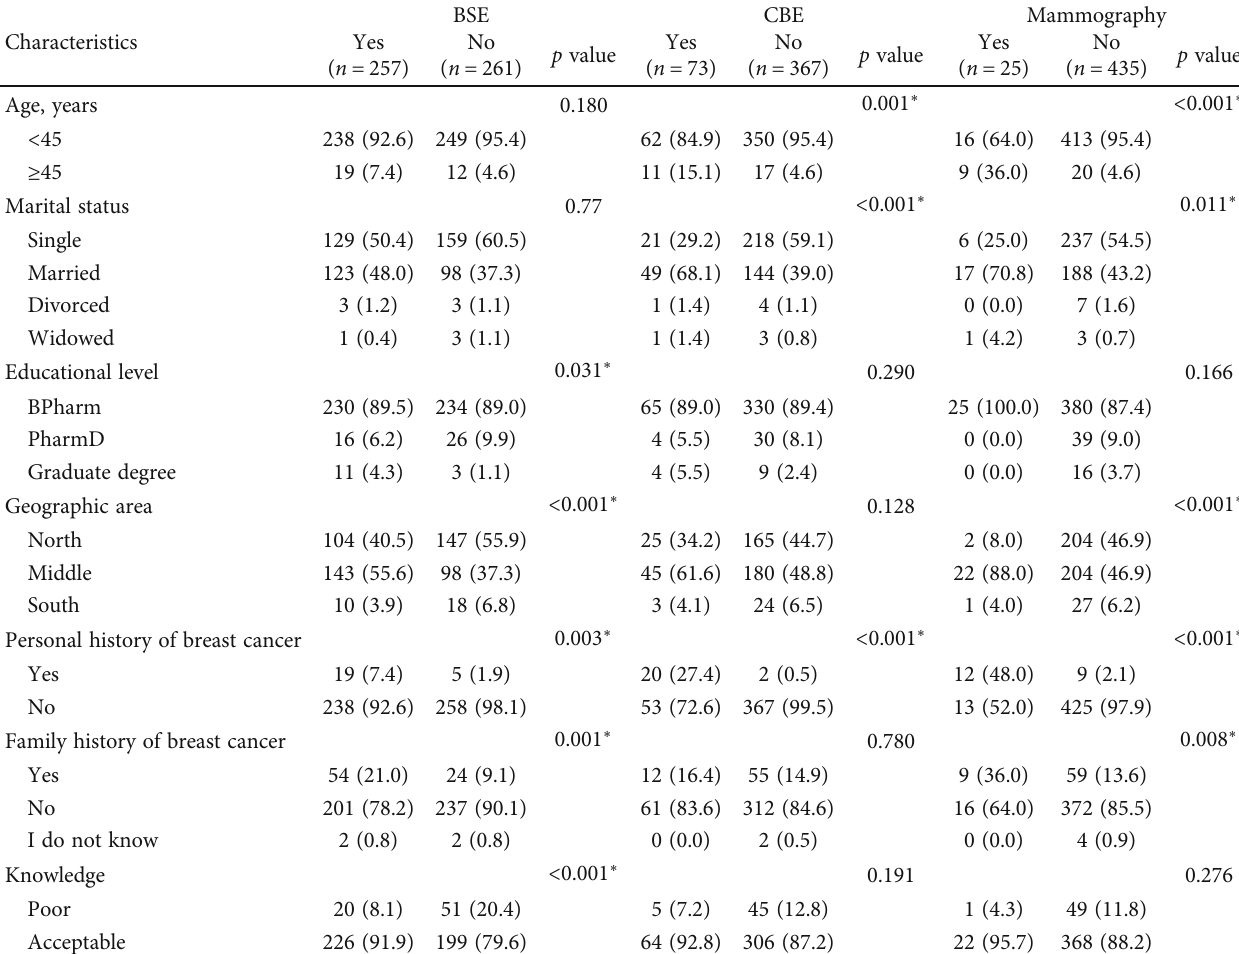
Table 5: Association of screening practices with demographic characteristics and knowledge of breast cancer among community